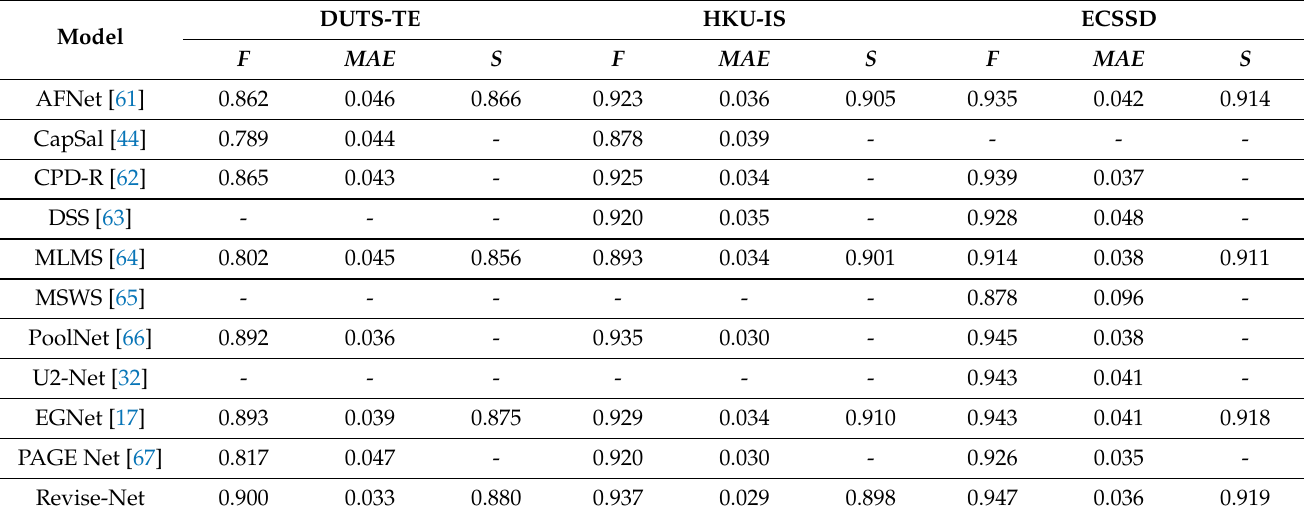
Table 1. Comparison of the proposed Revise-Net with state-of-the-art baselines on DUTS-TE, HKU-IS and ECSSD datasets.